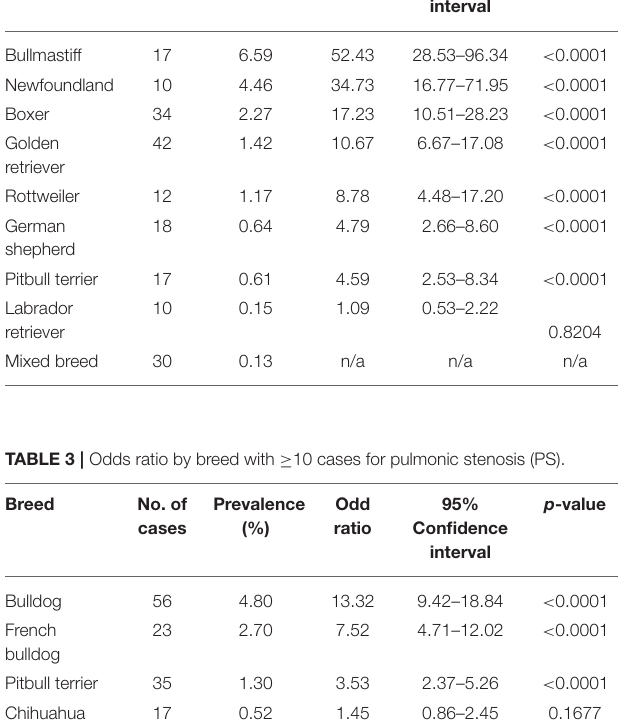
TABLE 2 | Odd ratio by breed with ≥ 10 cases for subvalvular aortic stenosis (SAS). Breed